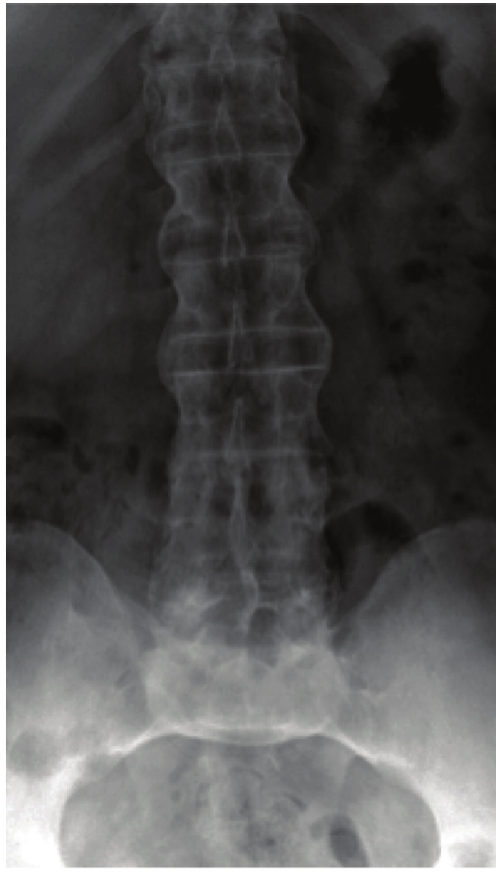
Figure 2: Postero-anterior radiography showing the ankylosis of sacroiliac joints (grade IV) and multiples syndesmophytes of the vertebral bodies (“bamboo” spine) in an asymptomatic patient. The radiography was performed when discovering a Schober test of 0